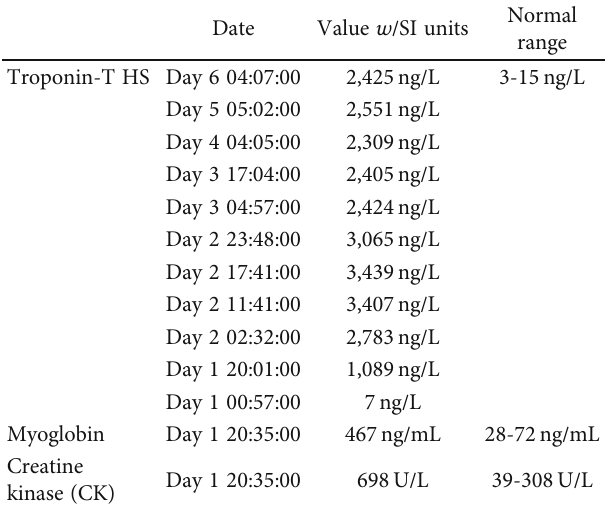
Table 2: The results of cardiac markers carried out after the patient developed chest pain. Date Value w /SI units